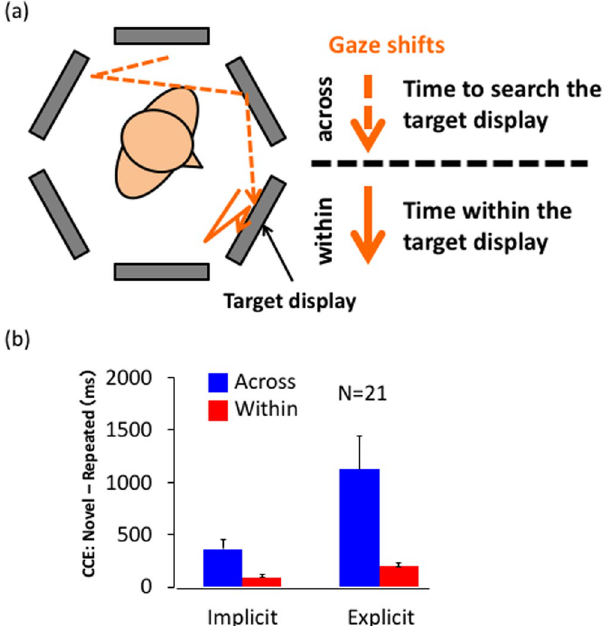
Figure 3. ( a ) Division of RT into within- and across-display periods. The within-display RT is the time to search for the target within the target display, and the across-display RT is the time to search for the target display. The time of first look of the target display was defined by the head orientation, the time when the head oriented to the target display. ( b ) CCE of within- and across-display RTs. The differences between novel and repeated layouts were calculated separately for within- and across-display RT. The RT results for the 0° display were not used.